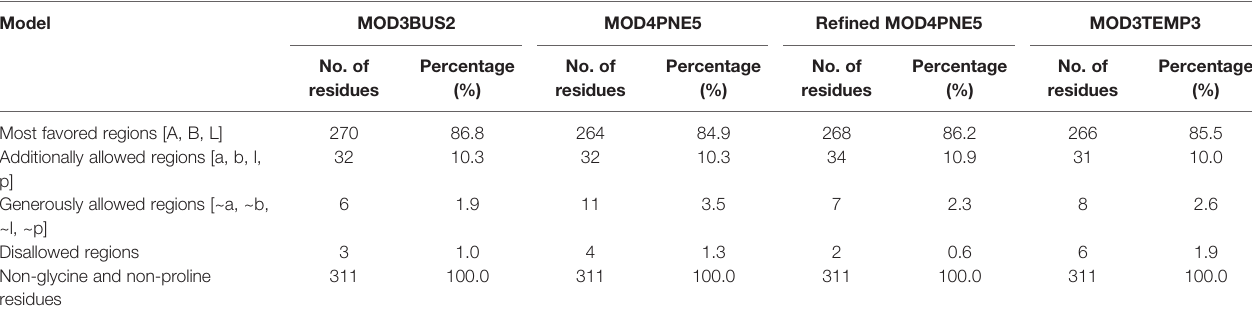
TABLE 1 | Ramachandran plot statistics for the best models from the three modeling approaches. Model